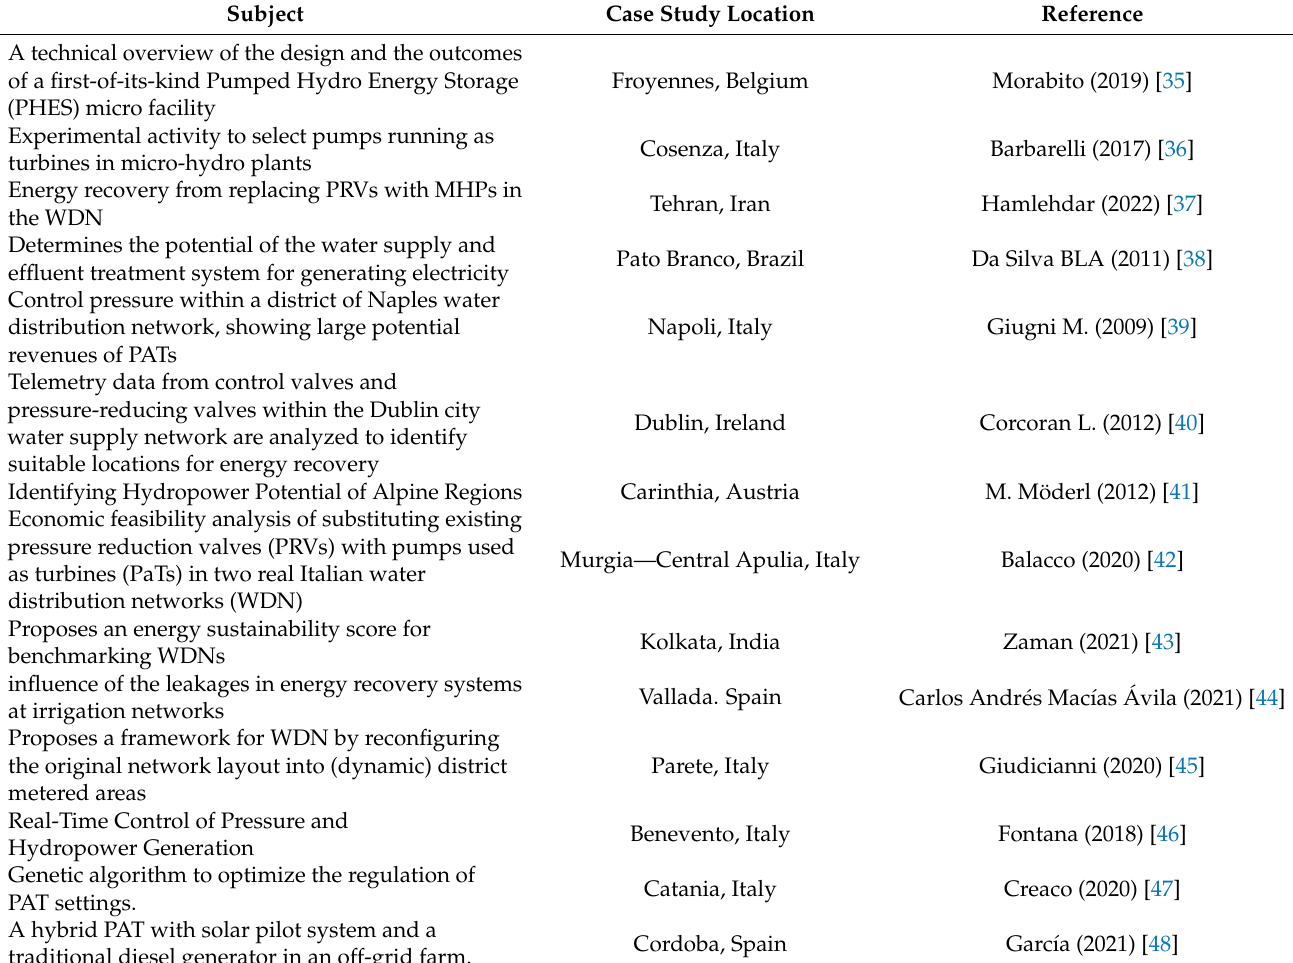
Table 1. Case studies of energy